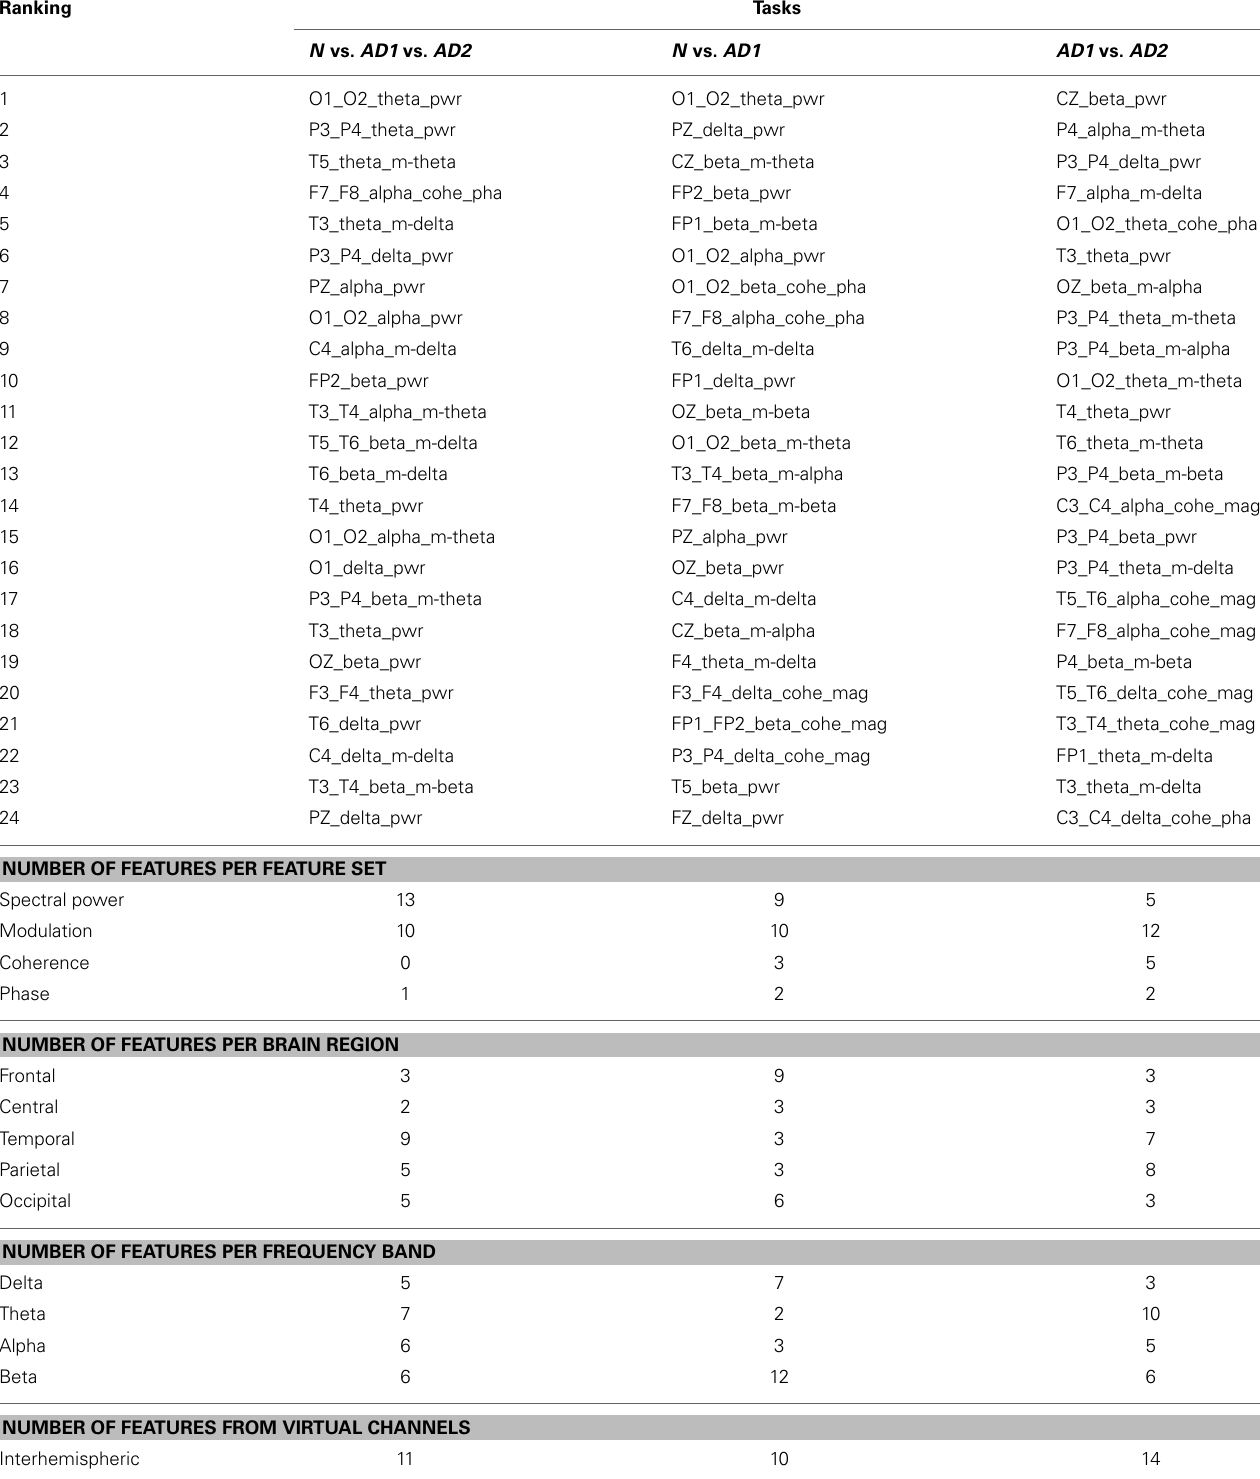
Table 6 | Selected features used with the gold standard system. Ranking